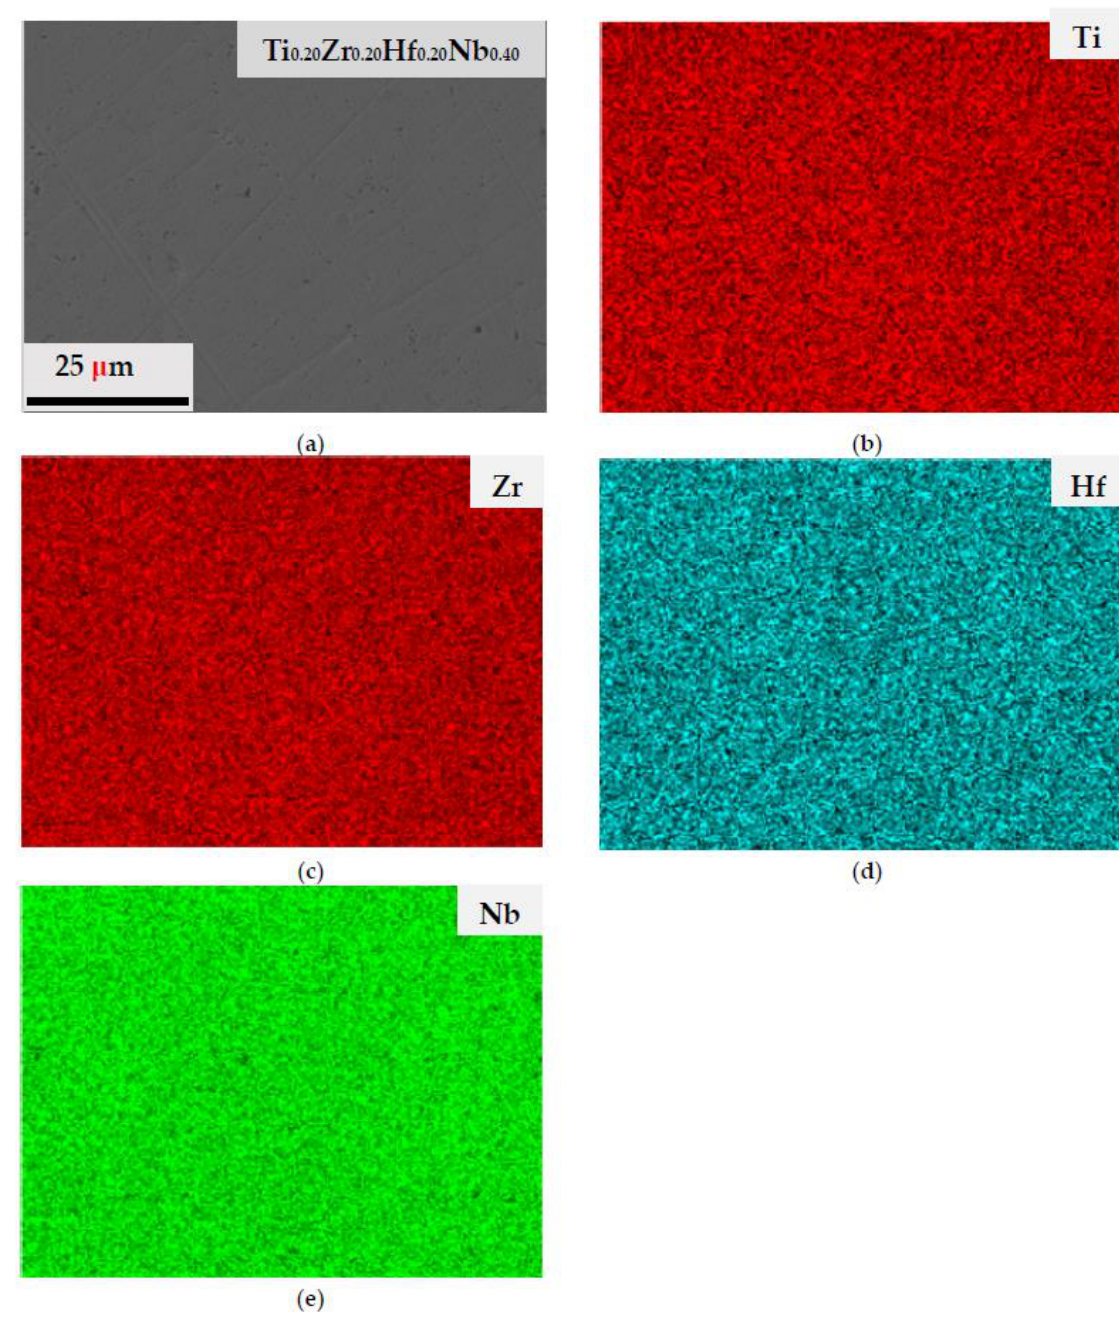
Figure 1. ( a ) SEM image of Ti 0.20 Zr 0.20 Hf 0.20 Nb 0.40 high entropy alloy (HEA). The energy dispersive spectroscopy (EDS) maps of ( b ) Ti, ( c ) Zr, ( d ) Hf and ( e ) Nb elements on the sample surface of ( a ) showed homogeneous distributions of all four metal elements.